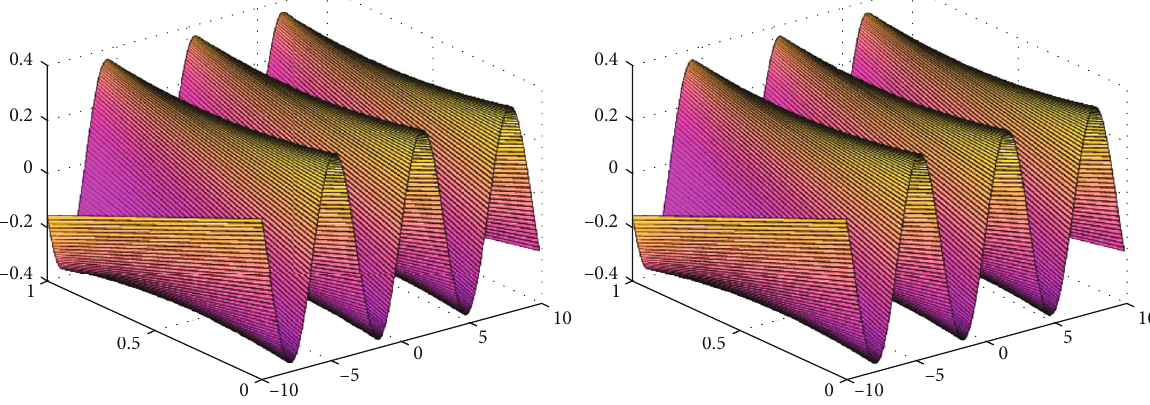
Figure 6: Graph of exact and analytical results of Problem 3.